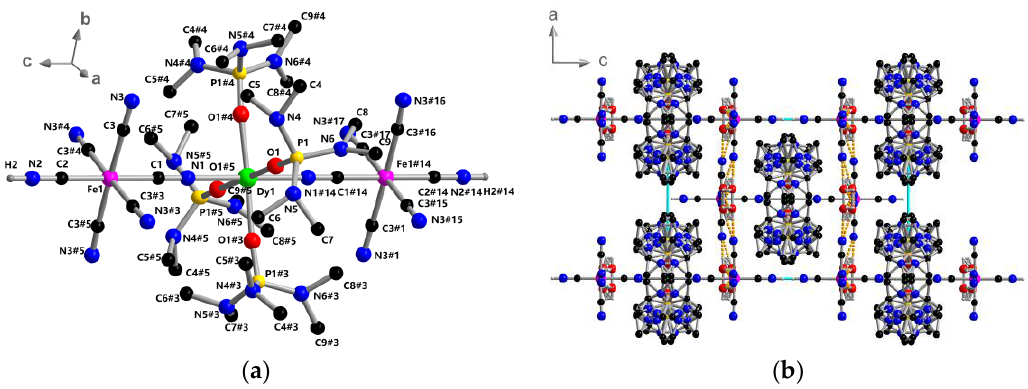
Figure 1. The molecular structure of compound 2 : ( a ) The coordination environment of the Dy(III) ions. Symmetry codes: #1 −x, −y, −z; #3 y, −x, z; #4 −y, x, z; #5 −x, −y, z; #14 x, −y, −z; #15 y, −x, −z; #16 x, y, −z; #17 −y, x, −z; ( b ) The packing diagram of compound 2 along the b -axis.